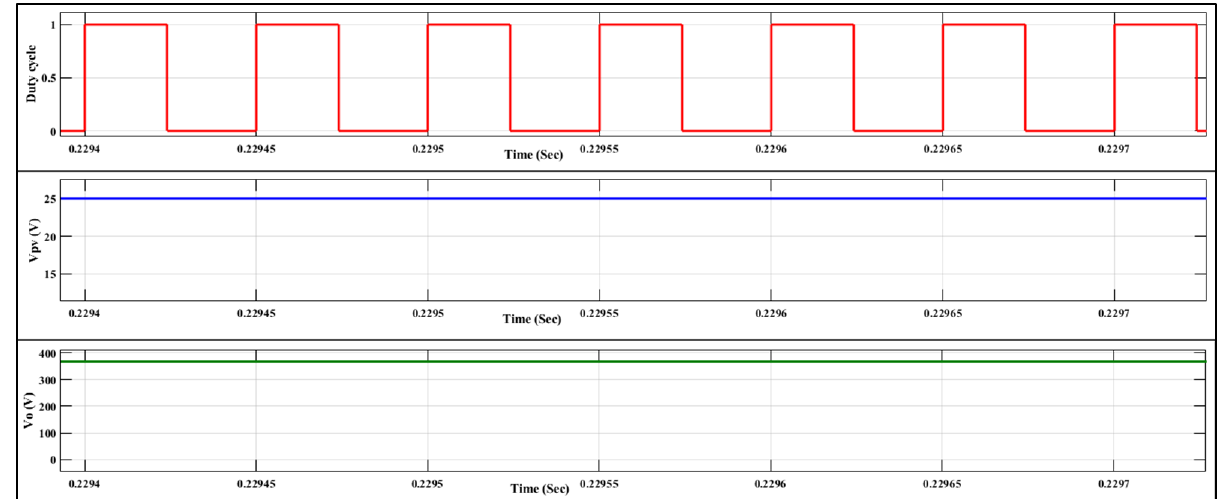
Figure 10. Simulated waveform for solar PV module output voltage (V pv ) and output voltage (V o ) of the proposed HVGSU converter at the 0.48 duty cycle.